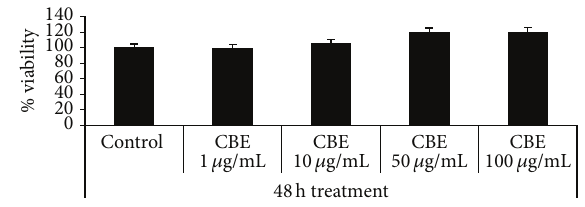
Figure 1: Effects of Citrus bergamia extract (CBE) on mesenchy- mal stem cells viability, determined using the 3-(4,5-dimethyl-2 thiazolyl)-2,5-diphenyl-2H-tetrazolium bromide (MTT) assay, after 48 hours of treatment with 1, 10, 50, or 100 𝜇 g/mL of CBE. The values of optical density measured at 𝜆 = 550 nm are reported as percentage with respect to the optical density registered for untreated control (Control), the latter considered as 100% of cell viability. The values are mean ± SD of three experiments performed in